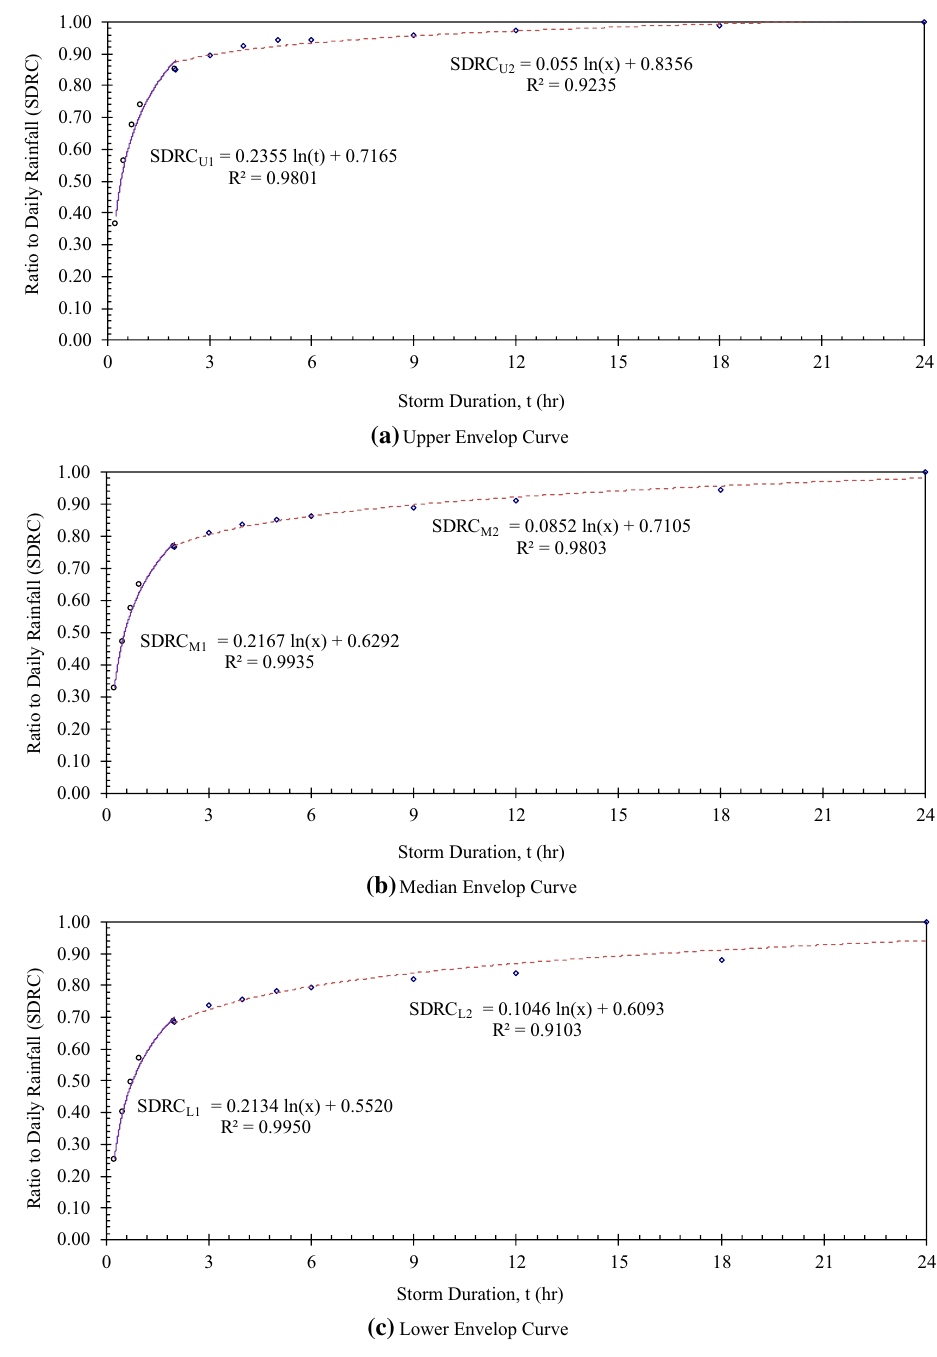
Fig. 5 Charts and regression equations for short-duration rainfall coefficients